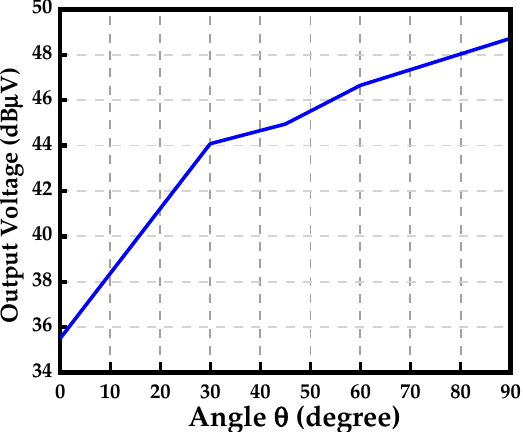
Figure 14. Output voltage of the tangential electric-field sensor illuminated by a plane wave.